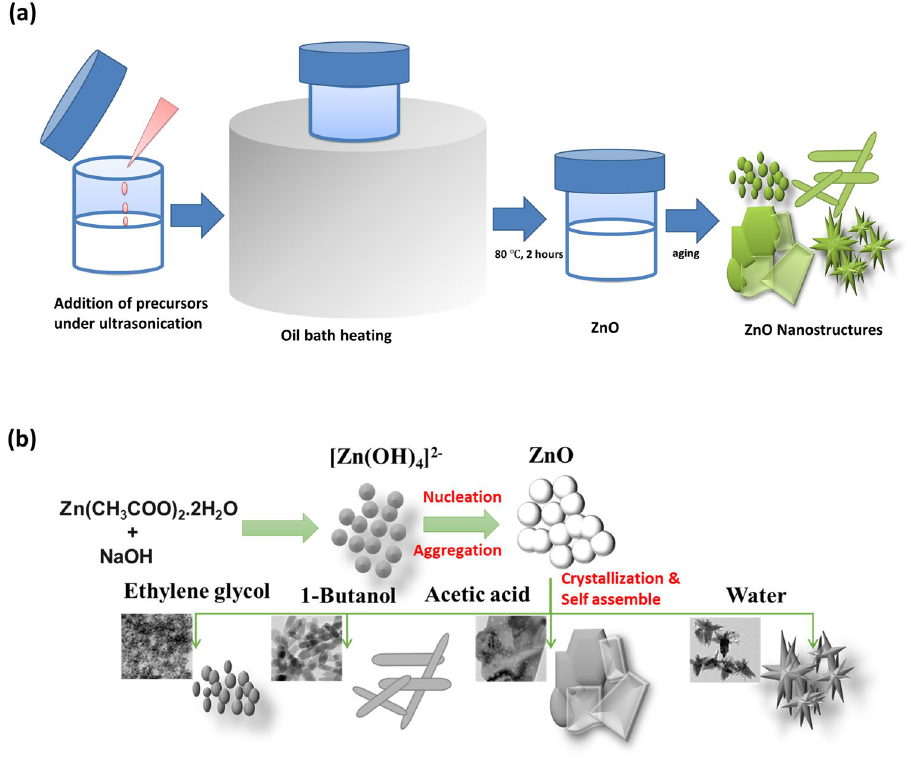
Figure 5. Schematic diagram of ( a ) synthesis procedure ( b ) growth mechanism of ZnO nanostructures in the distinct solvents.